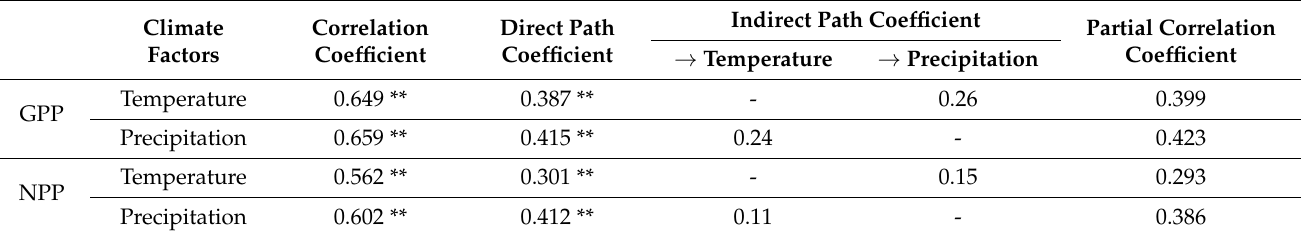
Table 4. Path analysis of temperature and precipitation to GPP and NPP.